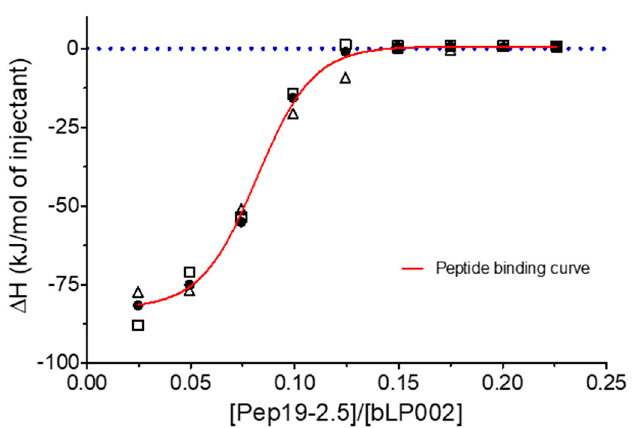
Figure 16. Binding study of the lipopeptide LP with Pep19-2.5 in ITC experiments. The [LP bLP002] = 0.2 mM was titrated with 1 mM Pep19-2.5 using 1 µ L in each titration. The data indicate an an S-shaped purely exothermic reaction with